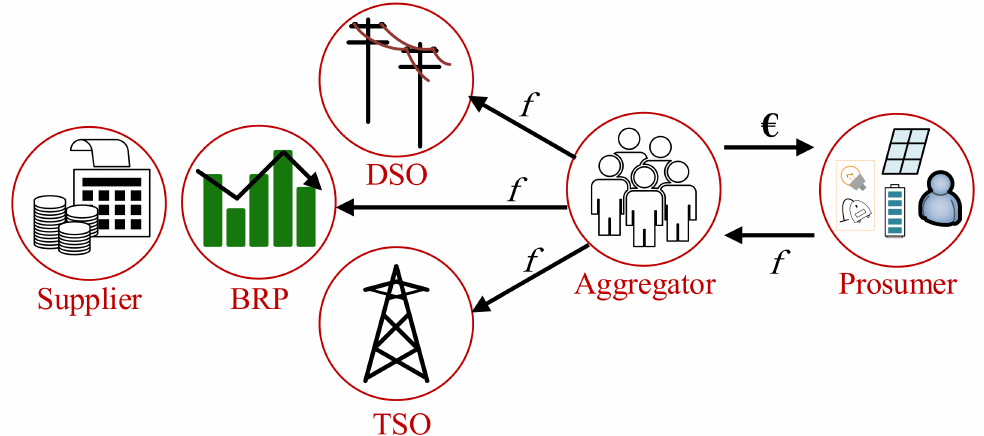
Figure 3. Flexibility provision of energy citizens in incentive-based DR and the remuneration of prosumers. In this figure, “ f ” indicates flexibility provision.